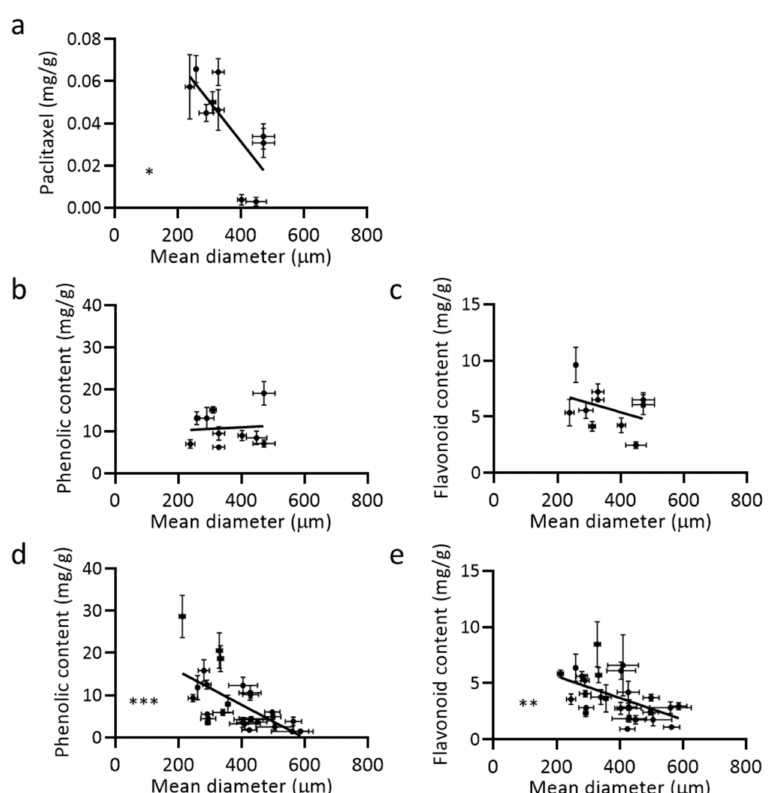
Figure 4. Correlation between mean aggregate size and metabolite accumulation is dependent on elicitation state. Paclitaxel ( a ), phenolic ( b , d ), and flavonoid ( c , e ) accumulation in elicited ( a – c ) and unelicited ( d , e ) P93AF+ cultures. Relationships were analyzed using the Pearson correlation coefficient (r); (a: n = 10, r = − 0.742), (b: n = 10, r = 0.079), (c: n = 10, r = − 0.364), (d: n = 27, r = − 0.614), and (e: n = 27, r = − 0.527). Each data point is the average of 3 biological replicates. (Error bars = standard deviation) (* p ≤ 0.05, ** p ≤ 0.01, *** p ≤